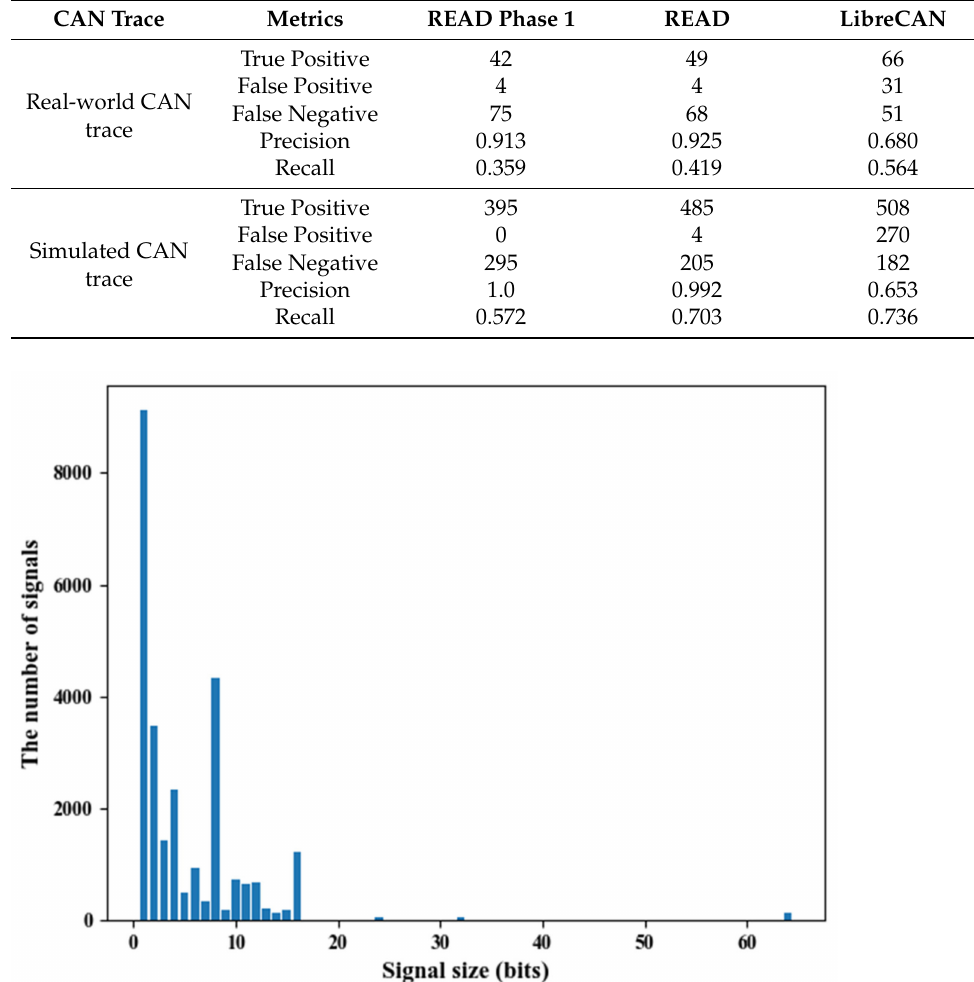
Figure 3. Distribution of sizes of all signals defined in the DBCs of OpenDBC